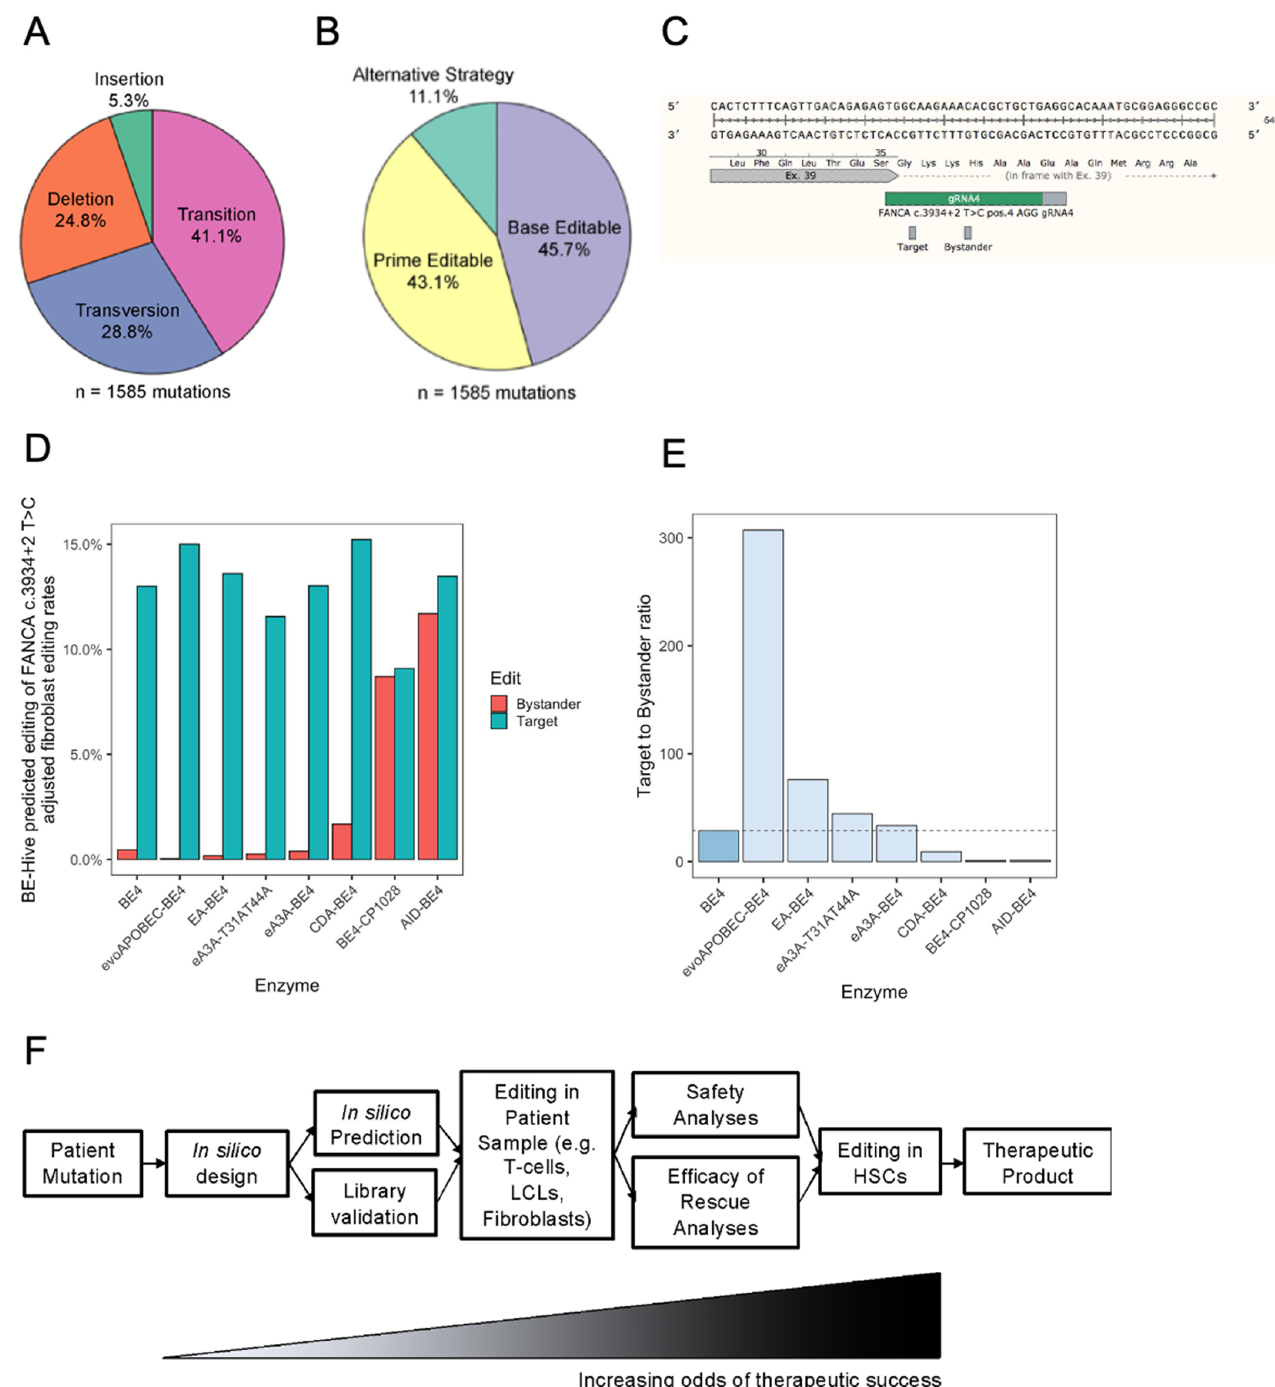
Figure 6. Computational assessment of the feasibility of digital editing for Fanconi Anemia muta- tions. ( A ) Piechart of ClinVar mutations showing the percentage of each mutation class; transition, transversion, deletion, and insertion mutations. ( B ) Piechart of ClinVar mutations correctable by digital editing strategies; base editing, prime editing. Mutations not correctable by digital editing are grouped under requiring alternative strategies. ( C ) Schematic of FANCA c.3934 + 2T > C locus with target and bystander bases when edited with CBE. ( D ) BE-Hive predictions of CBE efficiencies for FANCA c.3934 + 2T > C, adjusted for observed editing rates in fibroblast experiments (Figure 3). ( E ) Target to bystander ratio of BE-Hive-predicted editing. ( F ) Proposed pipeline for the se- lection and validation of patient mutation correction by digital editors.